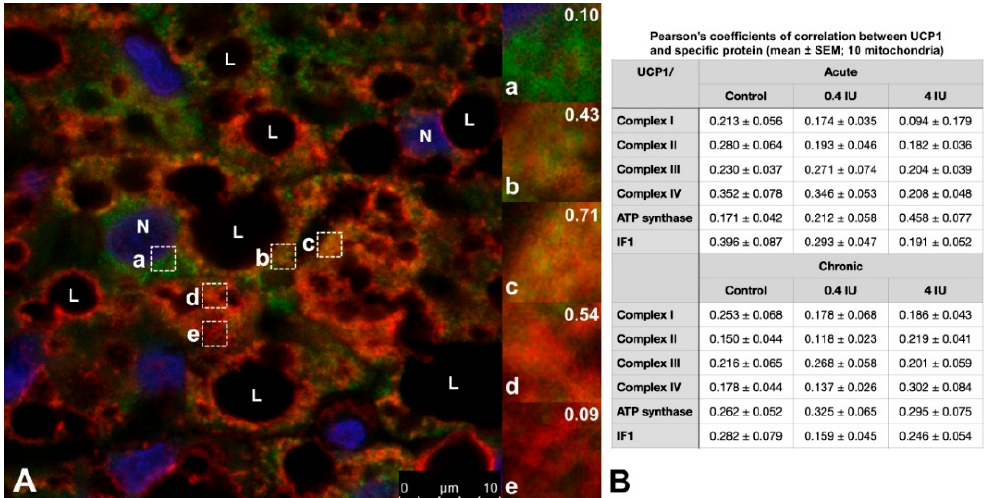
Figure 10. Representative images showing the Harlequin effect in brown adipocyte and the types of mitochondria. Double labeling with antibodies against UCP1 (green) and complex I (red). Nuclei were stained with Sytox Orange. ( A ) Representative BAT image from chronic low (0.4 IU) insulin group. Brown adipocytes showed various mitochondrial types: a. UCP1-only positive mitochondria; b. UCP1 predominantly positive mitochondria; c. UCP1 and complex I colocalized mitochondria; d. complex I predominantly positive mitochondria; e. complex I-only positive mitochondria. Pearson’s coefficient of correlation is shown in the upper right corner for each type of mitochondria. ( B ) Pearson’s coefficients of correlation between UCP1 and specific protein (mean ± SEM; 10 mitochondria within single brown adipocyte from each group). Scale bar = 10 µm ( A ).